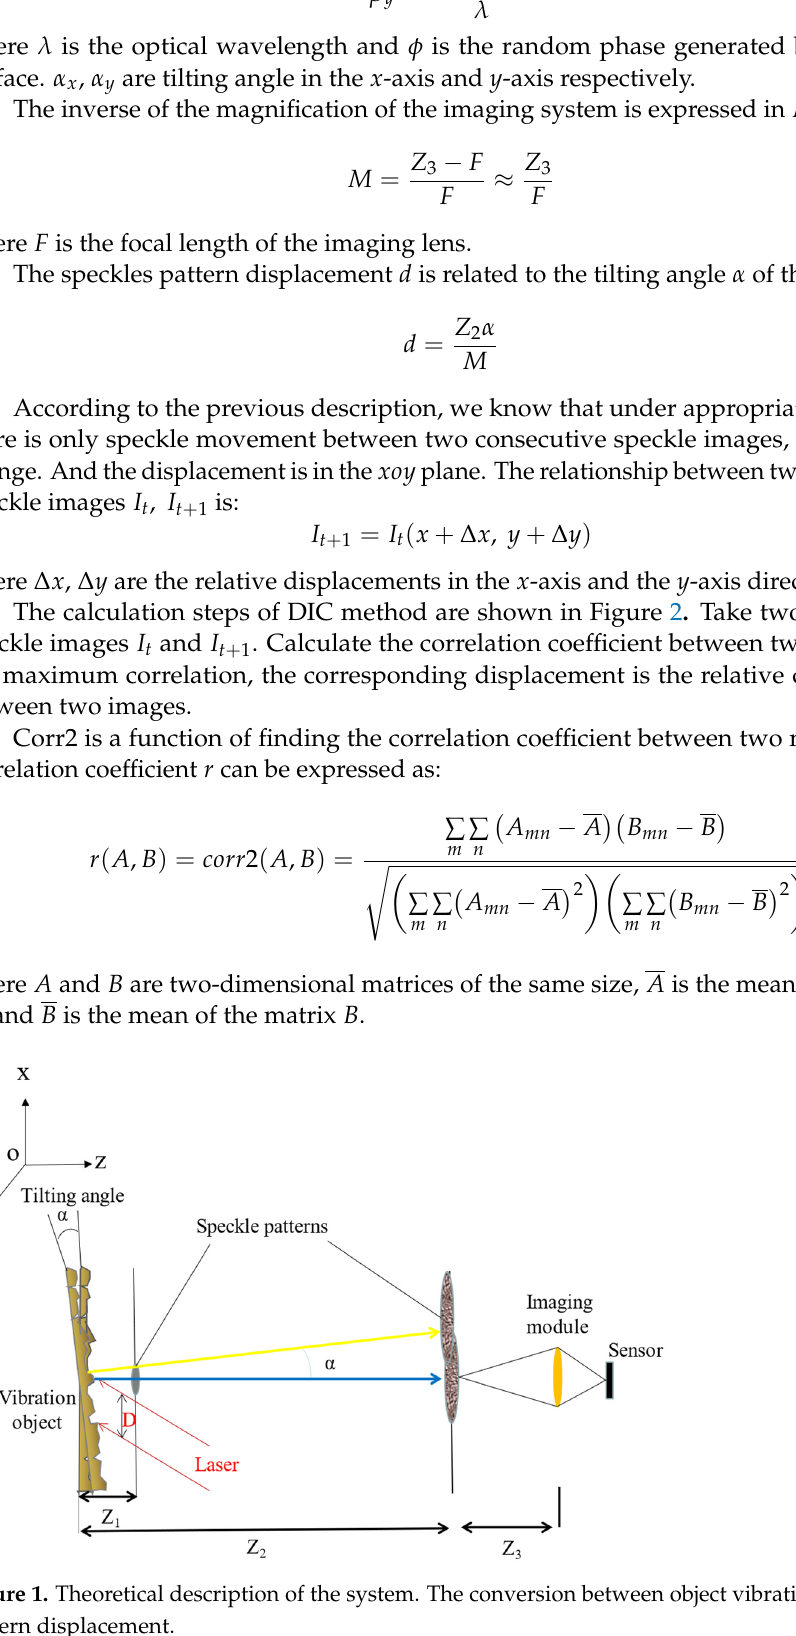
Figure 2. Digital image correlation method. 2.2. Speech Enhancement Algorithm We use a sinusoidal signal which frequency varies from 80 to 1600 Hz and amplitude remains constant as the audio at the sound source (Figure 3 shows the waveform and frequency spectrum of the sinusoidal signal), and collect the corresponding speckle image dataset. Then use the algorithm in Section 2.1 to reconstruct the sinusoidal signal when the vibration object is a carton (Figure 4 shows the waveform and frequency spectrum of the reconstructed signal). By comparing Figure 3 with Figure 4, we found that the ampli ‐ tude of the reconstructed signal is different at different frequencies, which seriously af ‐ fects the accuracy of the reconstructed speech signal. Figure 5 is the reconstructed signal when the vibration object is a paper cup. By comparing Figure 4 with Figure 5, we found that the frequency responses of two different vibration objects are also different.